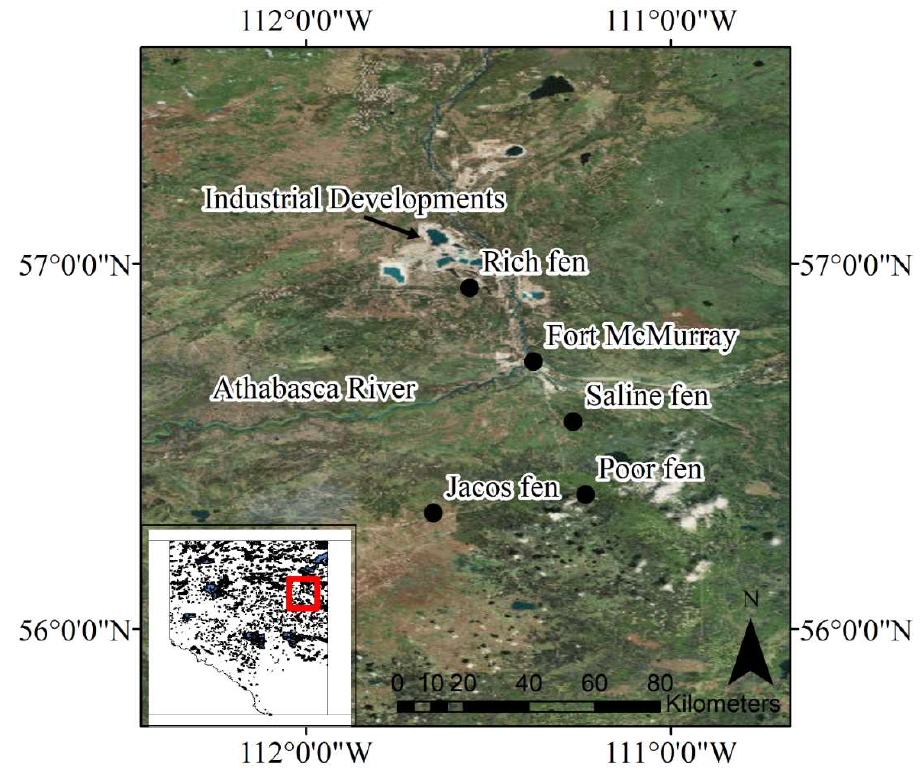
Figure 1. Location of the study sites (dark circles) relative to active industrial development hub in the Athabasca Oil Sands Region, near Fort McMurray, Alberta, Canada (inset map). The rich fen site is adjacent to industrial development centers to the North whereas the JACOS fen is located within an in-situ disturbance lease.